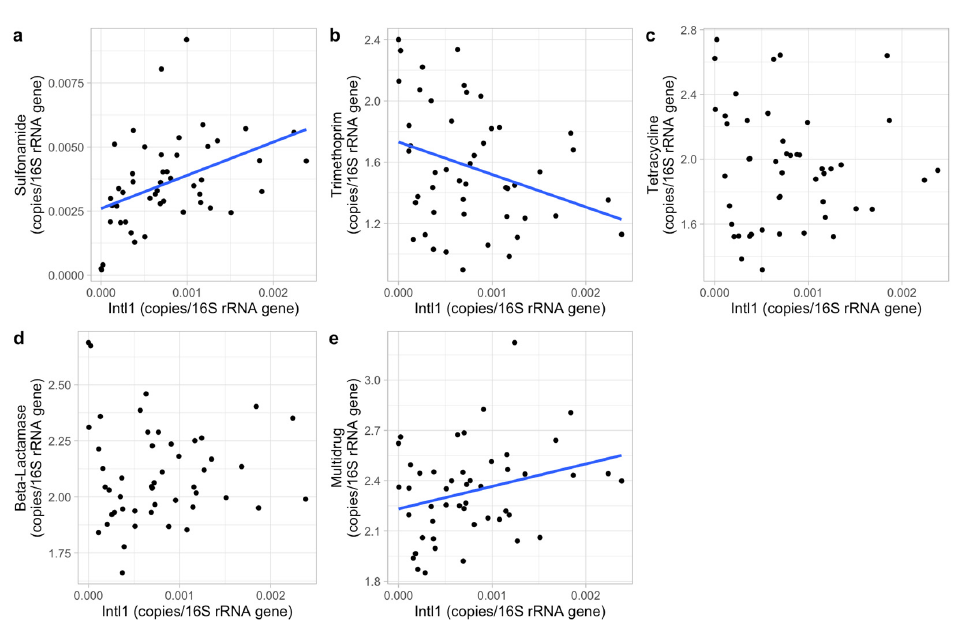
Figure 5. The relative concentration of the intl1 gene (copies/16S rRNA gene) for each ARG class (( a ), sulfonamide; ( b ), trimethoprim; ( c ), tetracycline; ( d ), beta-lactamase; ( e ), multidrug). The ARG concentration was log 10 (x*10 6 ) transformed except for sulfonamide to meet normal distributions. Significant relations are shown by the blue lines indicating the linear regression line for each data set.